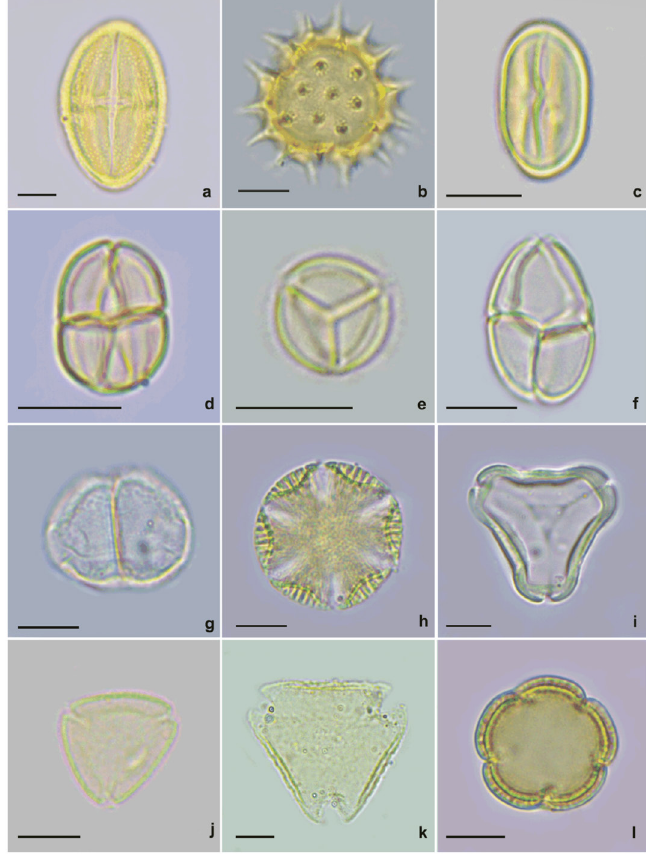
Figure 4. Predominant and secondary pollen types